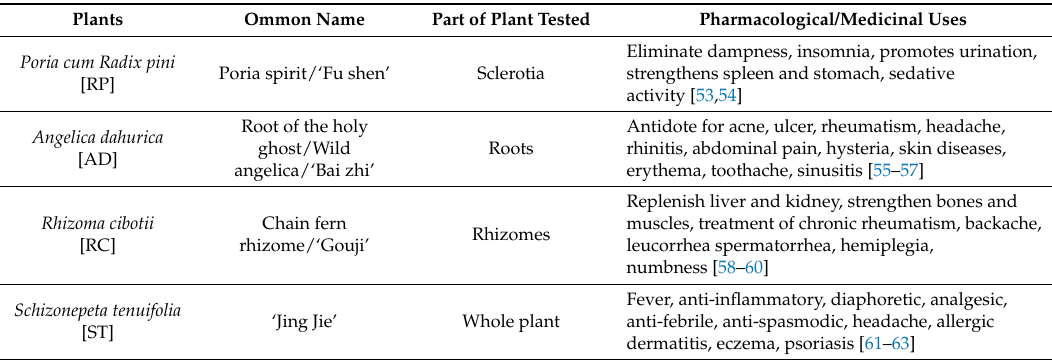
Table 2. Plants tested for anti-quorum sensing (QS)